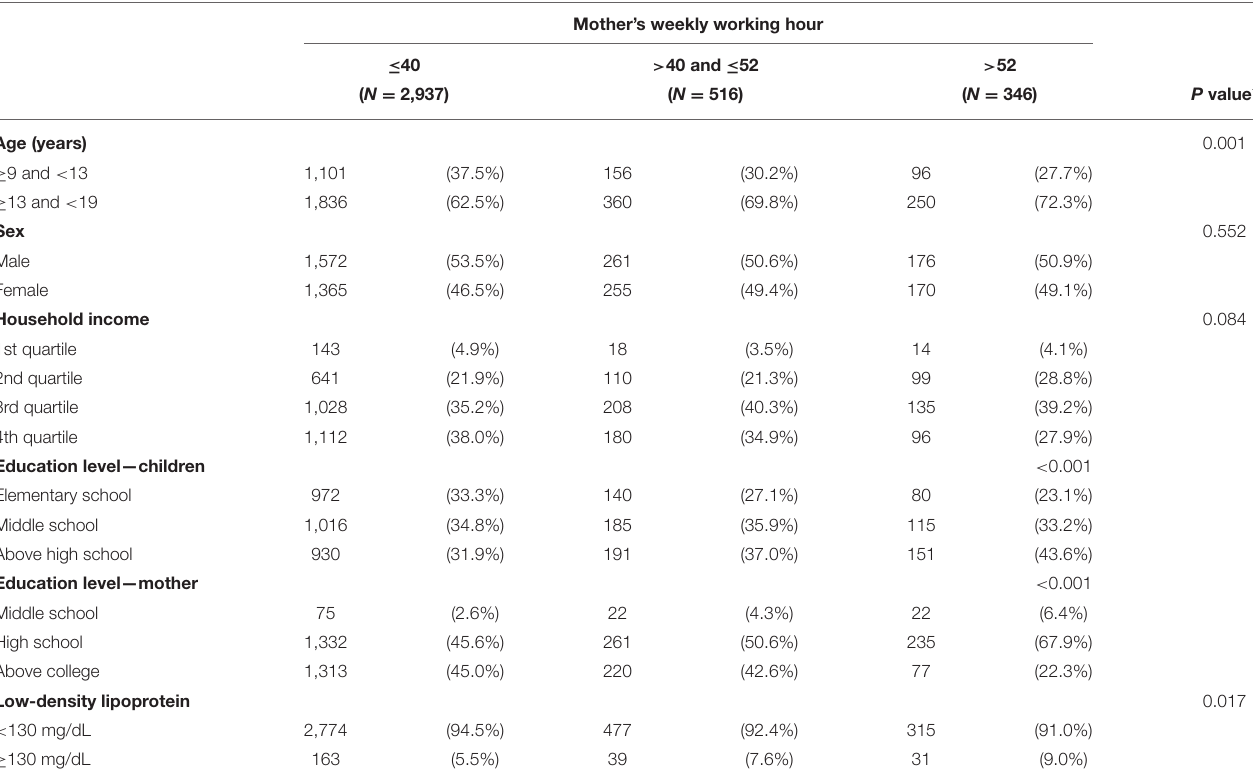
TABLE 3 | Baseline characteristics of study participants divided by working hours of the mother.